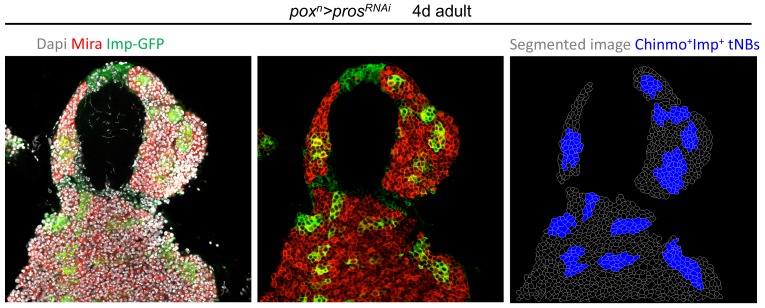
Segmentation of NB tumors Segmented confocal section of a tumor using Tissue Analyzer.Anti-Mira staining was used as membrane reference. Accurate segmentation was manually double-checked using Dapi as nuclear marker. Imp-GFP+ cells represent Chinmo+Imp+ tNBs. GFP- tNBs represent Syp+E93+ tNBs.